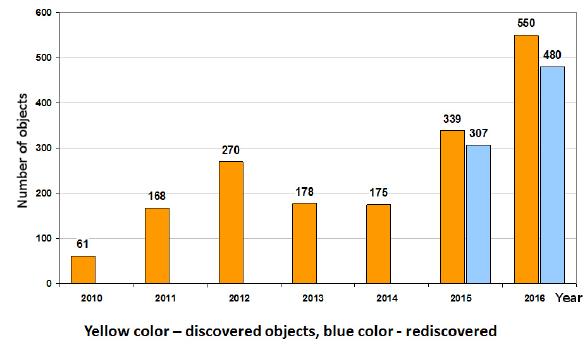
Figure 13. Statistics of discoveries and re-discoveries of ISON per year